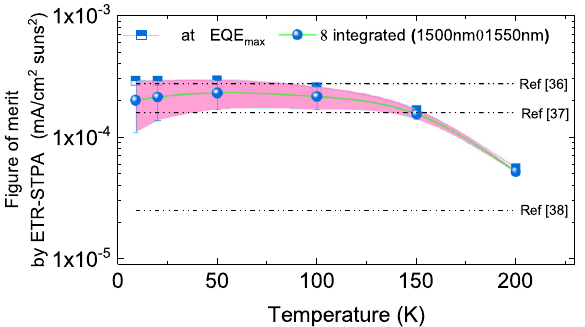
Fig. 8 Figures of merit plotted for solar cells enhanced by additional absorption of sub-bandgap photons from the sun. The blue dots show the fi gure of merit for our Er900 sample, which uses the sequential two-photon absorption (STPA) process via the ratchet state. The results of the fi gures of merit for other integration widths are represented in the fi lled area by using the variance of the calculated ζ determined by the fi gure of merit at the maximum differential external quantum ef fi ciency ( Δ EQE max ) spectra. We also show the best results for a thin- fi lm solar cell ( α -Si:H), an organic solar cell, and a crystalline wafer-based solar cell (c-Si) enhanced by the Er 3 + lanthanoid up-conversion effect reported in the literature 36 – 38